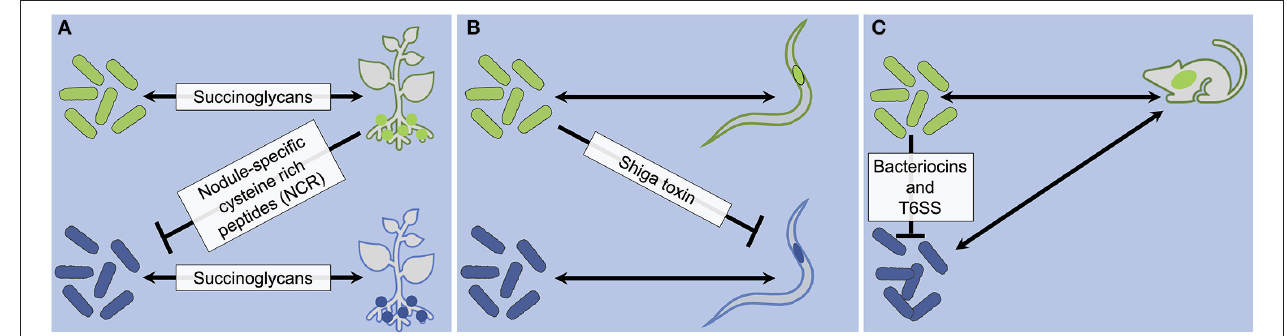
FIGURE 2 | Strain specificity factors that are involved in antagonistic interactions in S. meliloti-M. truncatula (A) , X. bovienii-Steinernema (B) , and bacteria-mice (C) associations. Strain-specific associations are indicated by matching colors in microbes and hosts.